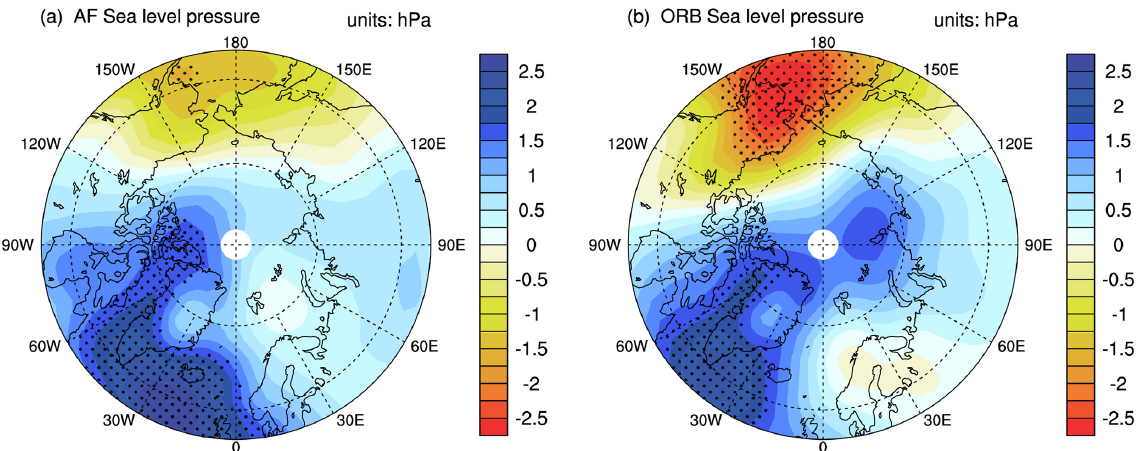
Figure 5. (a) The DJF sea level pressure changes between two period (0–2 and 5–8ka) in the NNU-Hol All forcing simulation. (b) Same as (a) but for the ORB forcing simulation. Areas that are dotted are significant at the 90% confidence